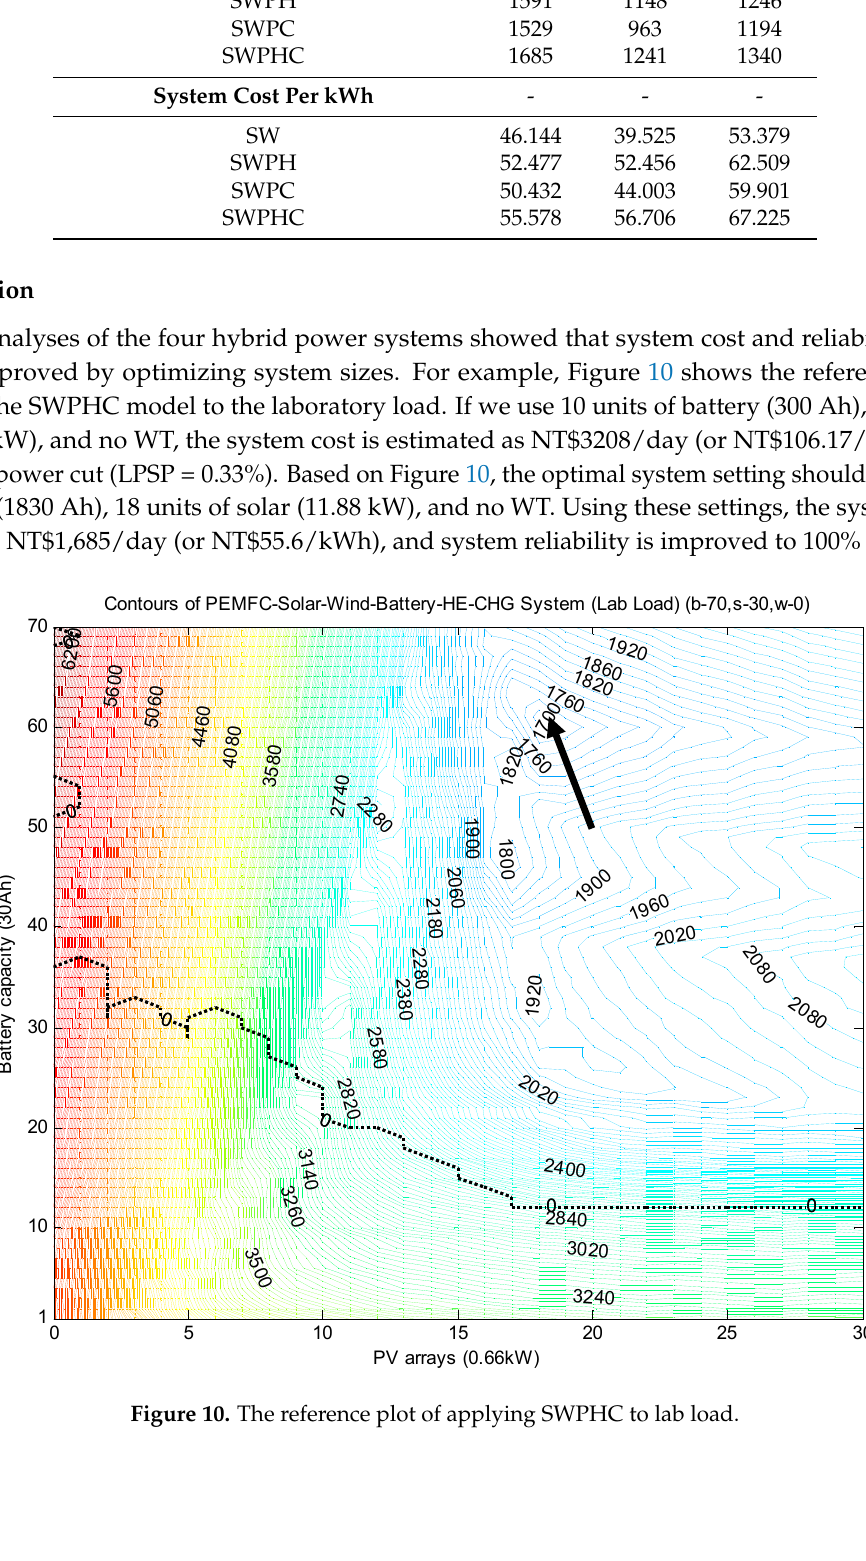
Table 3. Optimal system costs.